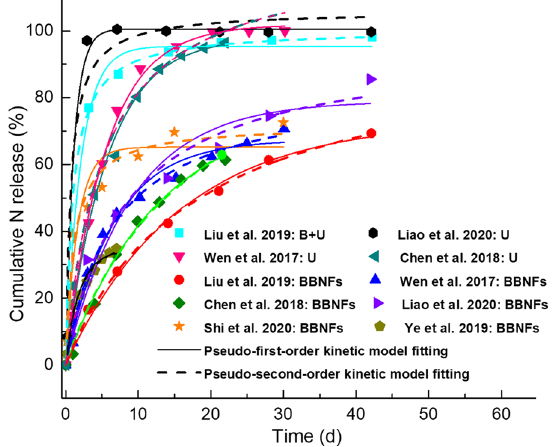
Fig. 2 N release rate comparing urea to BBNFs across published studies. U represents urea alone and B + U represents urea in combi- nation with